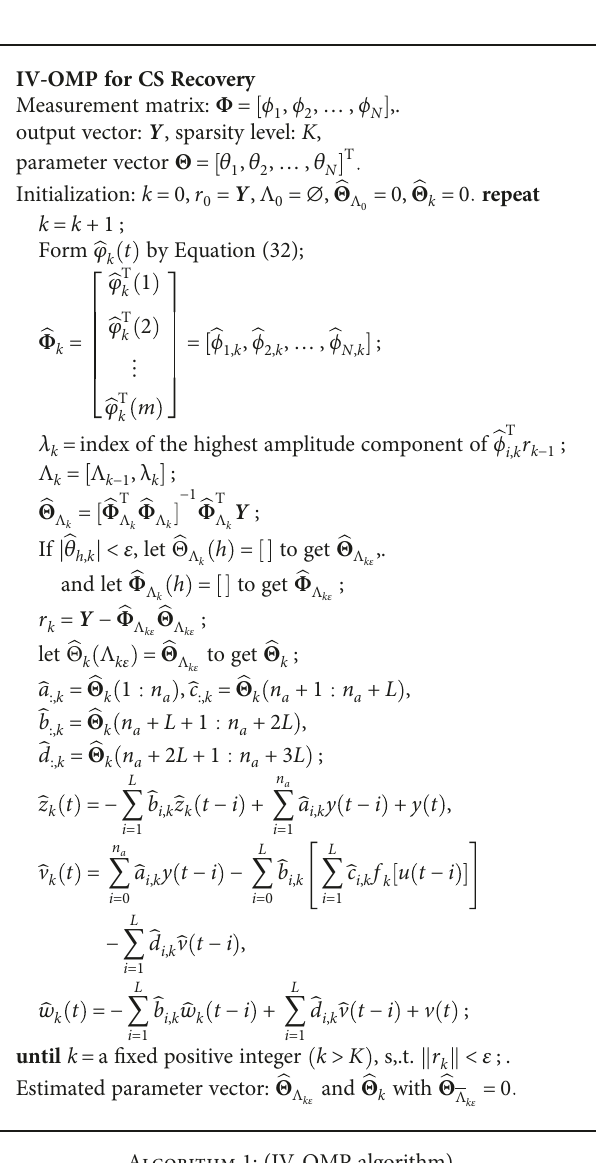
Algorithm 1: (IV-OMP